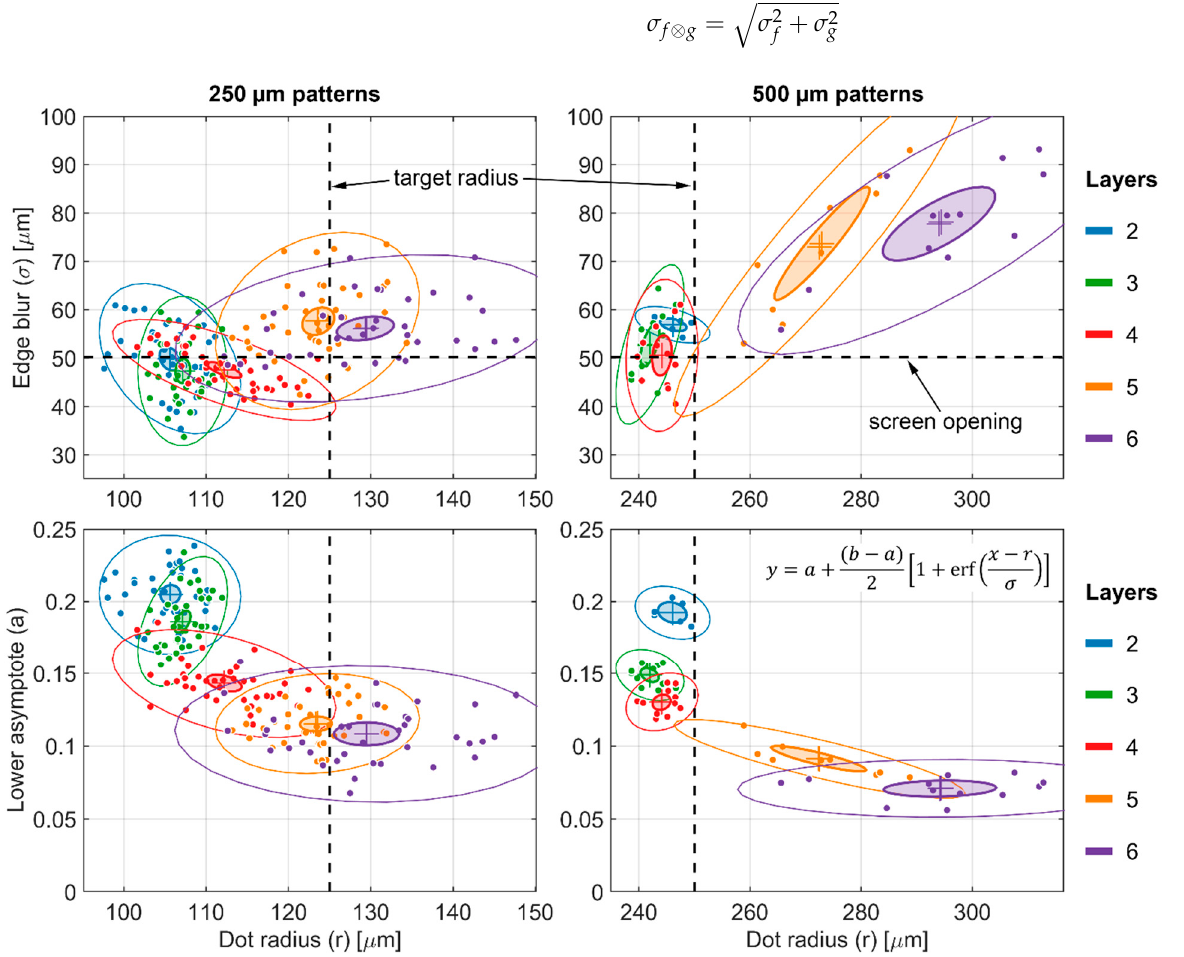
Figure 10. Error function fit statistics for BB dots imaged at BT2.